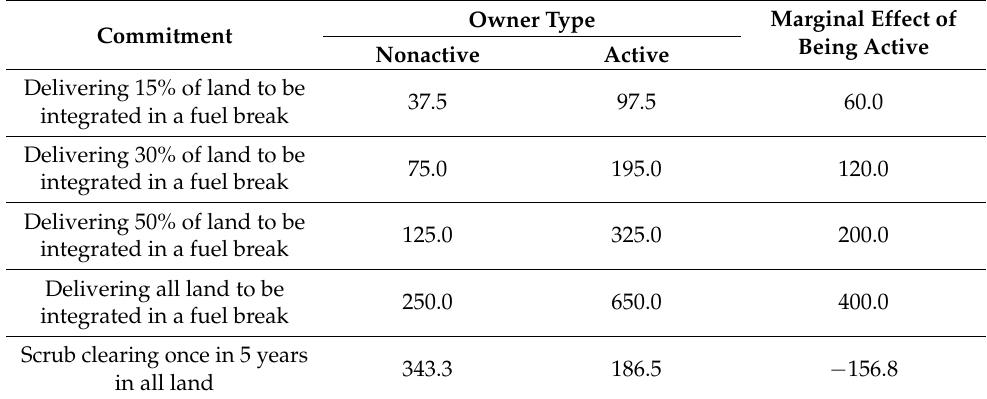
Table 4. Estimated minimum payment required by an owner to subscribe each particular